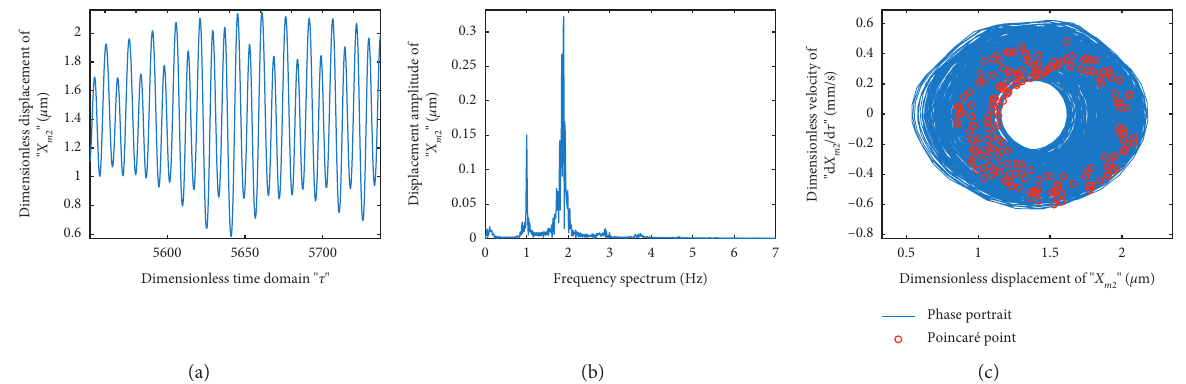
Figure 14: The dynamic response of system X m 2 at 17709rpm. (a) Time-domain response. (b) FFTspectrum. (c) Phase plane and Poincar´e point.